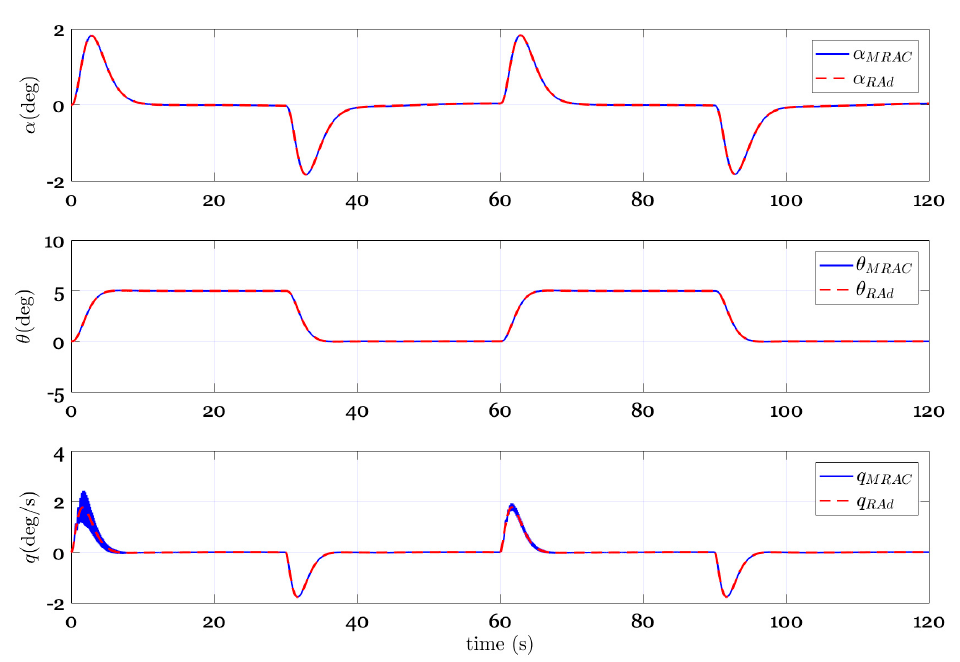
Figure 10. Aircraft response for MRAC and robust adaptive controller with ρ λ = ρ θ = 10 .